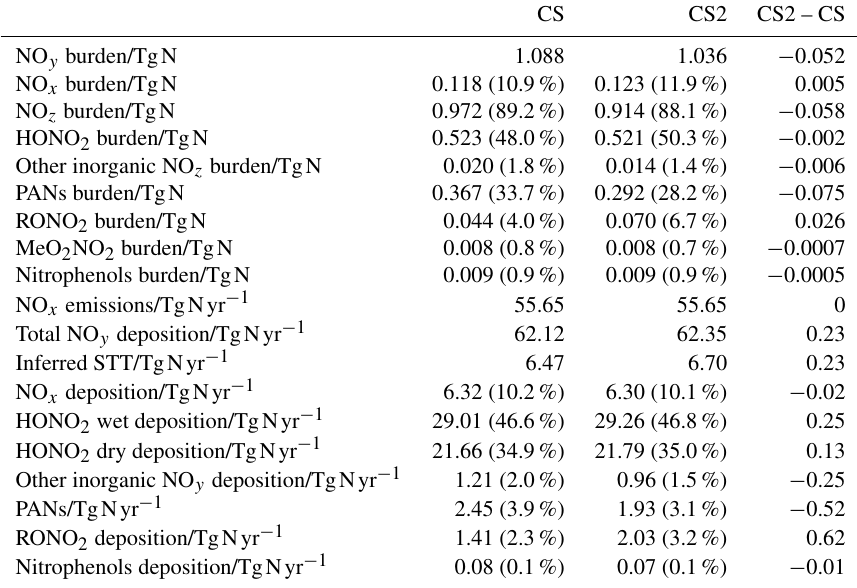
Table 8. Burdens of NO y and its constituent species, NO x emissions, NO y deposition, and inferred stratosphere-to-troposphere (STT) transport of NO y . Values in parentheses for burdens show the fraction of total NO y burden represented by each constituent and the fraction of total NO y deposition represented by each pathway for deposition